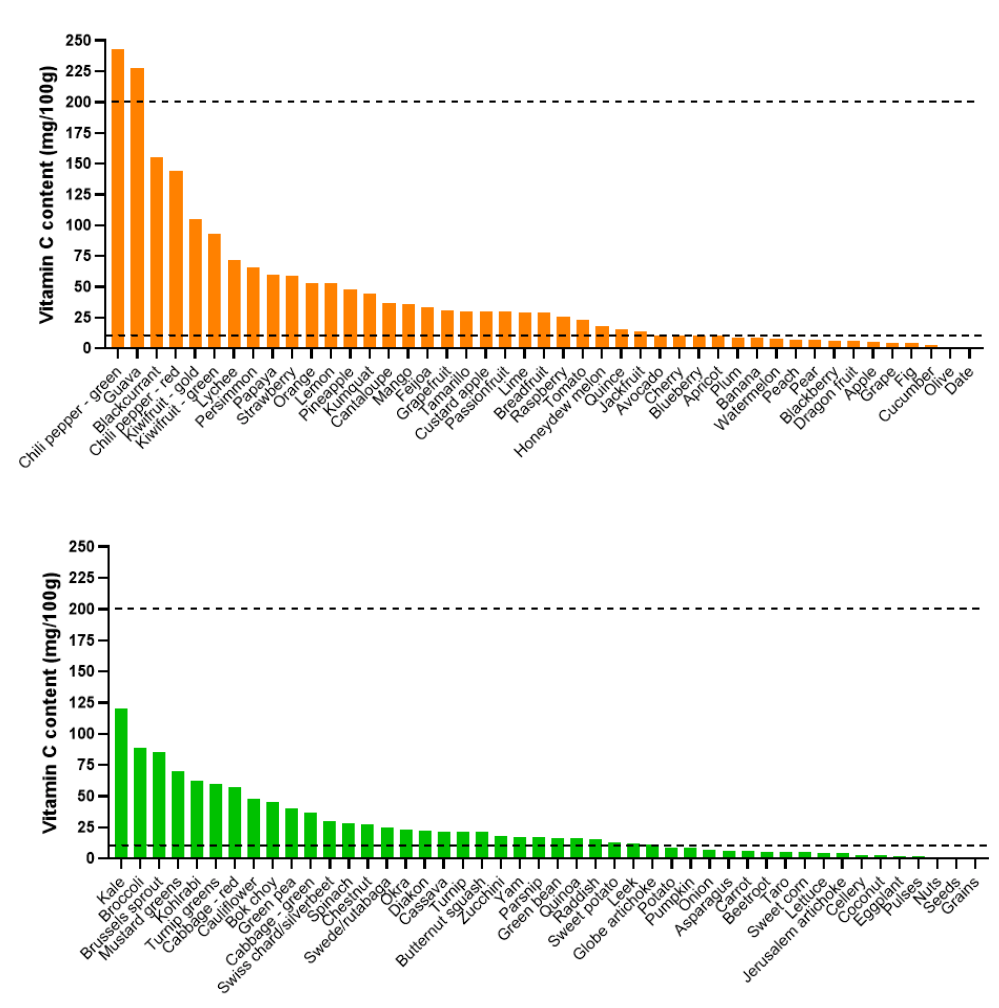
Figure 1. Estimated vitamin C content of selected fruit and vegetables. Data derived from the United States Department of Agriculture (https://fdc.nal.usda.gov/). Note that vitamin C content can vary depending on the plant variety, and cooking may decrease the vitamin C content to variable extents. Pulses include kidney beans, chickpeas, mung beans, pinto beans, soybeans, lentils, peanuts, split peas; nuts include hazelnuts, pistachios, macadamia nuts, pecans, walnuts, brazil nuts, cashew nuts; seeds include chia, flax seeds, pumpkin seeds, sunflower seeds, sesame seeds; grains include rice, millet, wheat/couscous, cornmeal. Animal products, such as meat (other than liver), eggs, and milk contain negligible vitamin C. Dotted lines: lower line indicates daily intake to prevent scurvy (10 mg/d); upper line indicates daily intake for optimal health (200 mg/d).